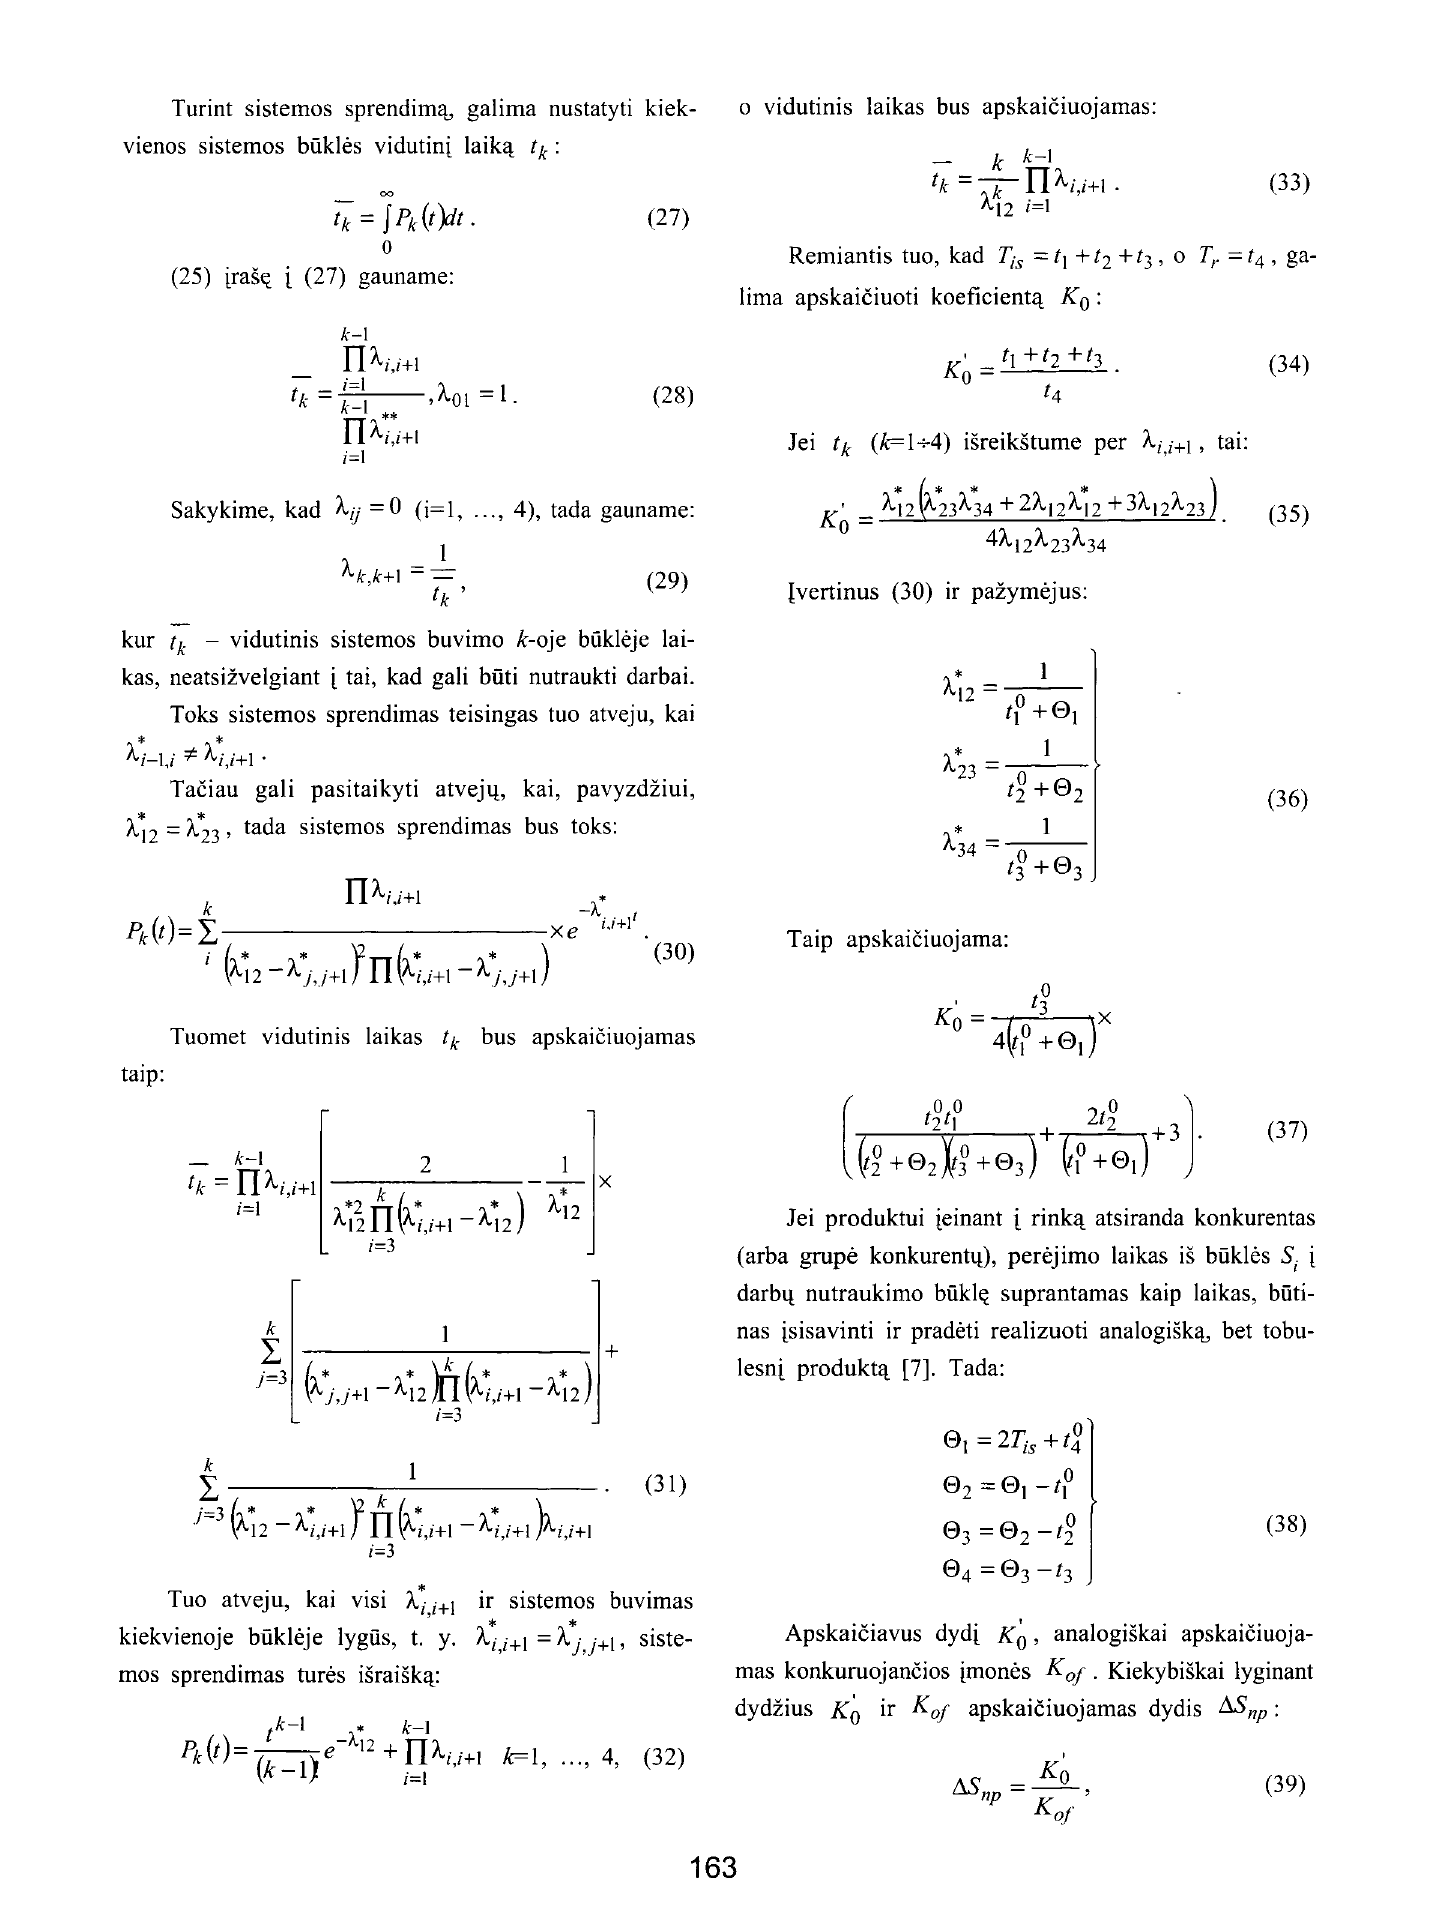
kur tk - vidutinis sistemos buvimo k-oje biikleje lai kas, neatsizvelgiant i tai, kad gali biiti nutraukti darbai. Toks sistemos sprendimas teisingas tuo atveju, kai A.~-1 i *A.~ i+1